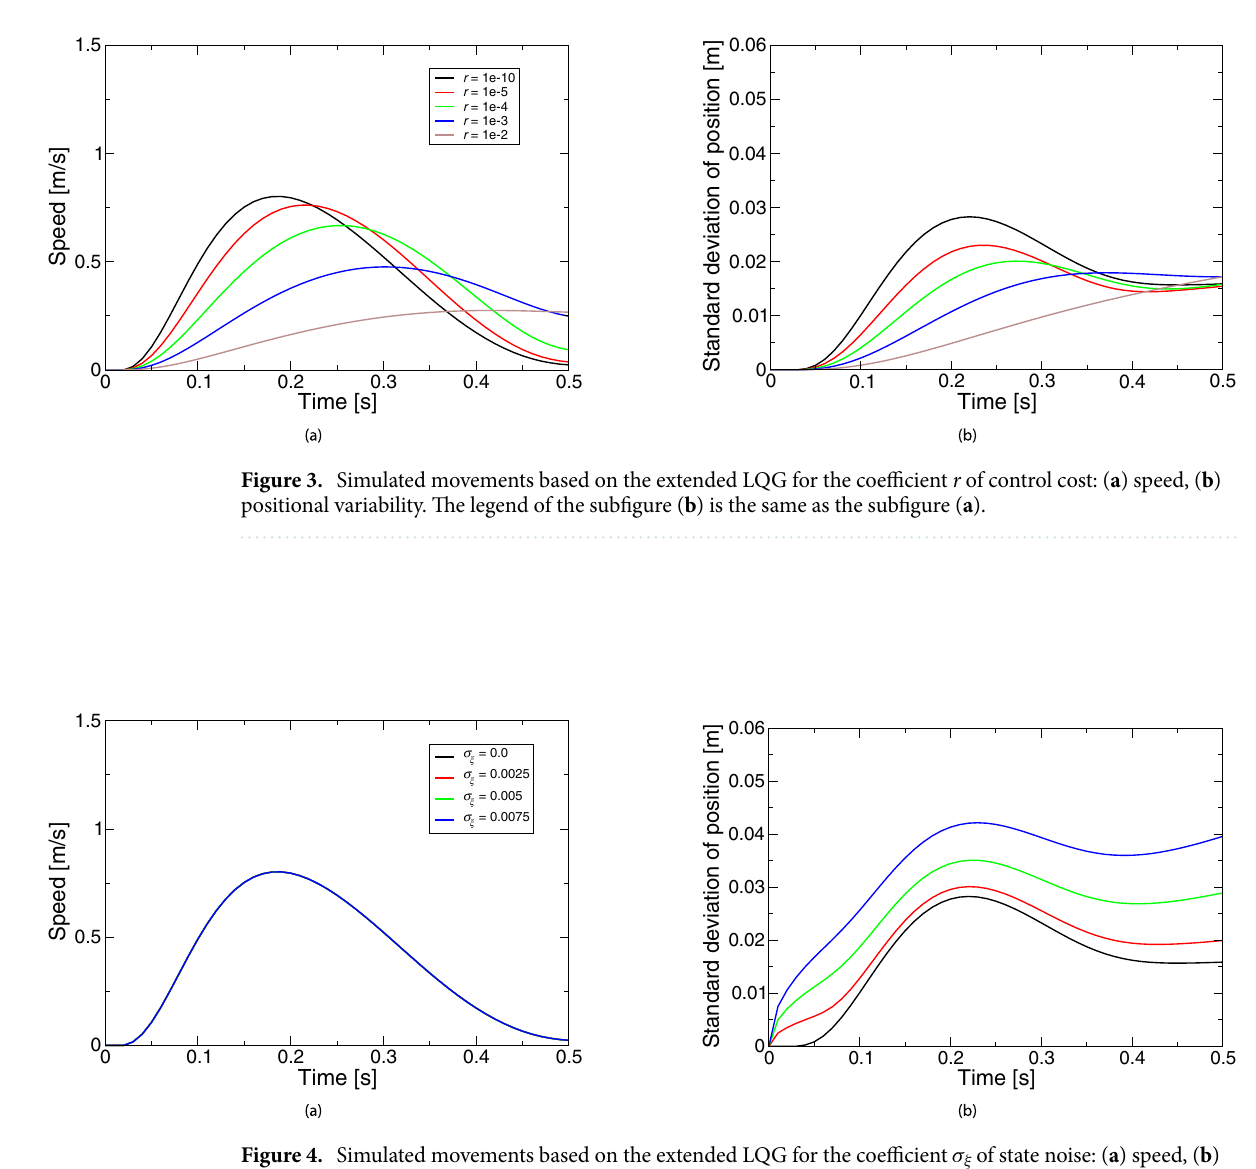
Figure 4. Simulated movements based on the extended LQG for the coefficient σ ξ of state noise: ( a ) speed, ( b ) positional variability. The legend of the subfigure ( b ) is the same as the subfigure ( a